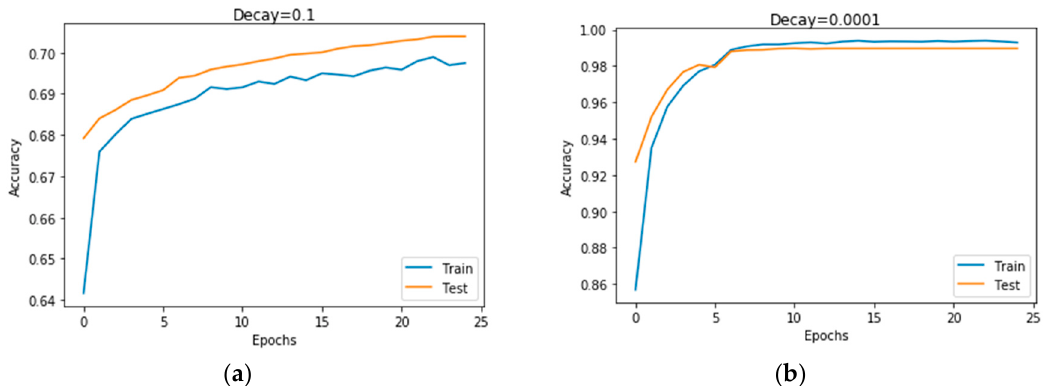
Figure 18. Recognition accuracy of the model with decay values of 0.1 and 0.0001. ( a ) shows that at higher value of 0.1 the model overfits whereas ( b ) shows that at lower values such as 0.0001, the system was able to generalize.